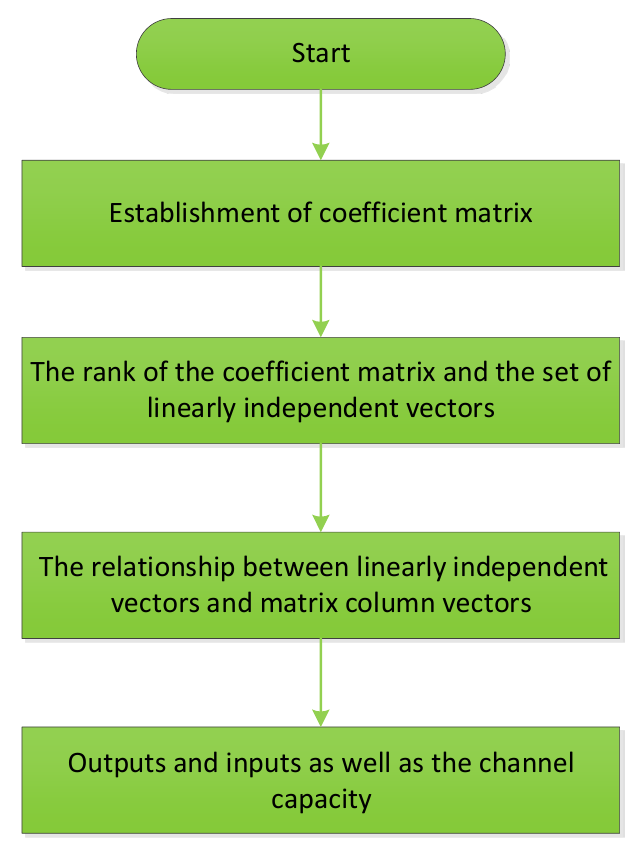
Figure 4. Flowchart of quantum zero-error coding based on linear transformation.